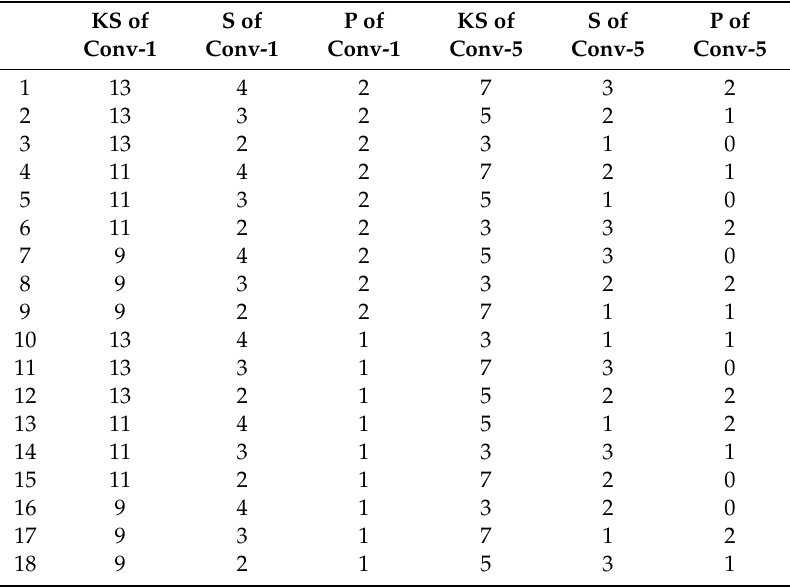
(cid:17) (cid:16) 2 1 × 3 5 orthogonal arrays. P